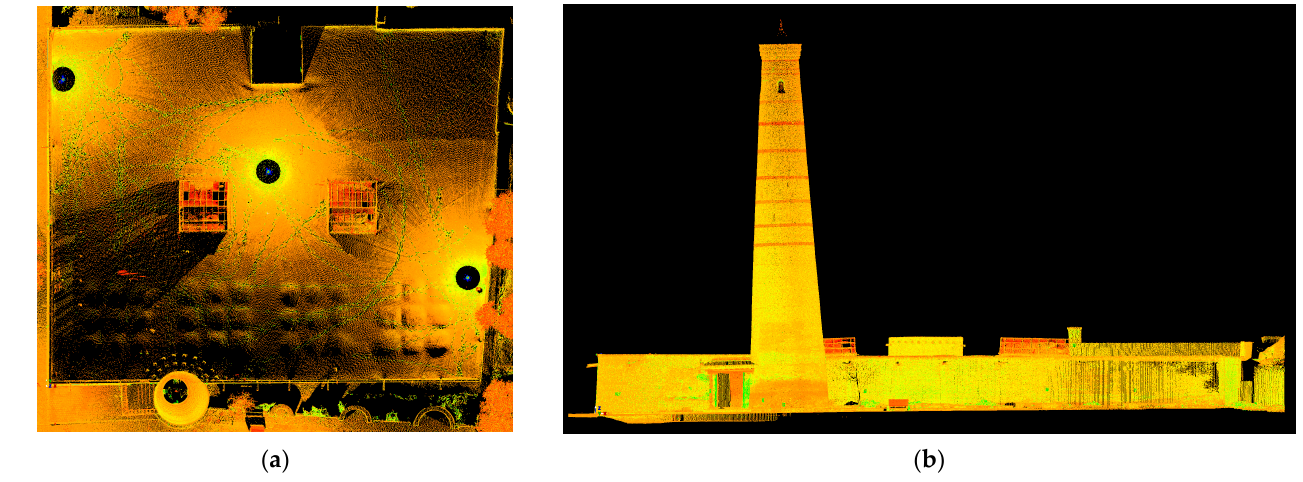
Figure 2. Elevation views of the monument’s point cloud: ( a ) plan view from the top; ( b ) elevation view from the north wall.